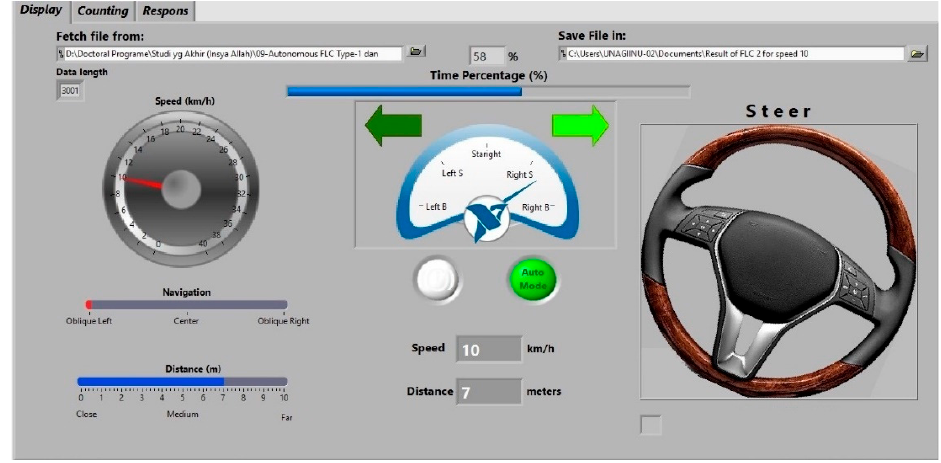
Figure 5. Autonomous vehicle simulation program.